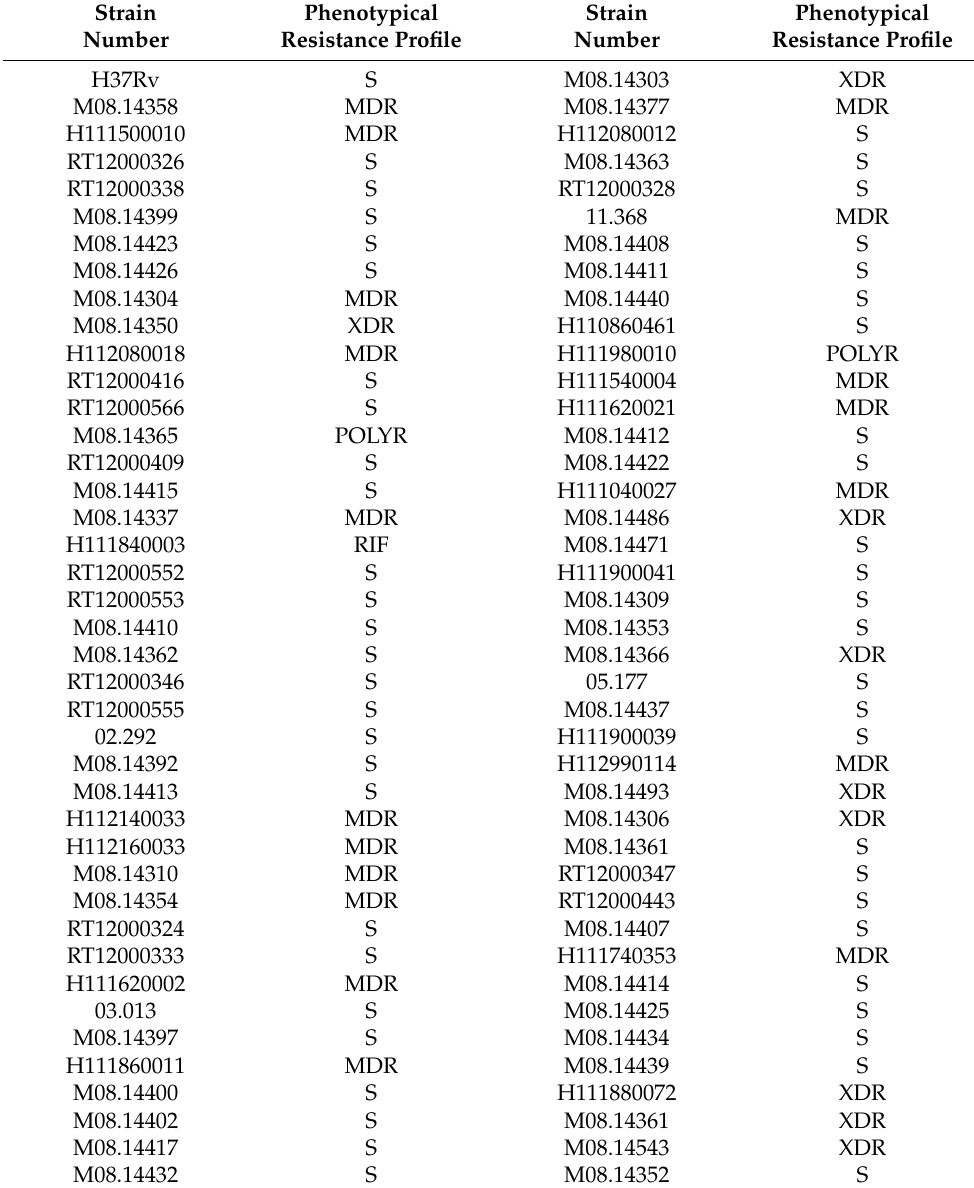
Table 5. Strains tested and their susceptibility profiles. S, fully susceptible; RIF, rifampicin-resistant; MDR, multi-drug resistant; POLYR, poly-resistant; XDR, extensively